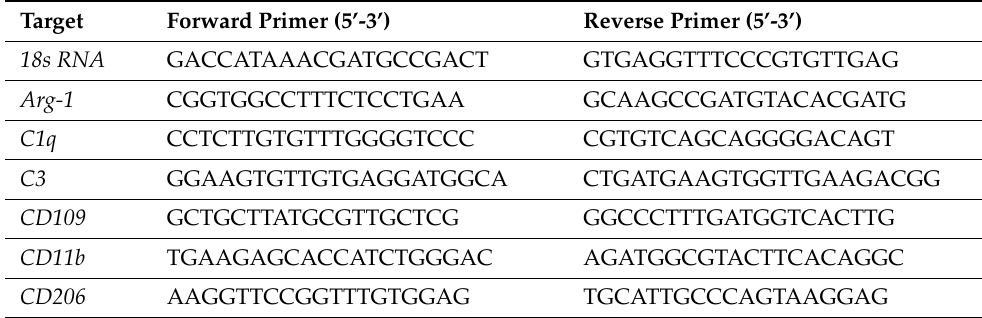
Table 1. Primers used in PCR